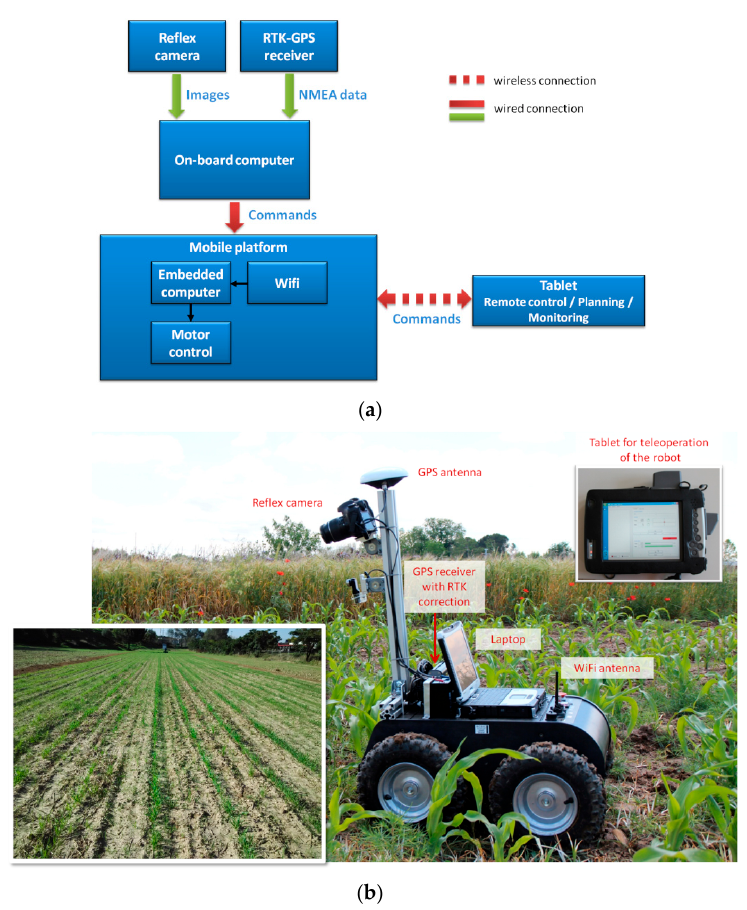
Figure 1. ( a ) The system architecture. ( b ) Devices integrated in the mBase-MR7 robot (right) and a maize crop field (left).